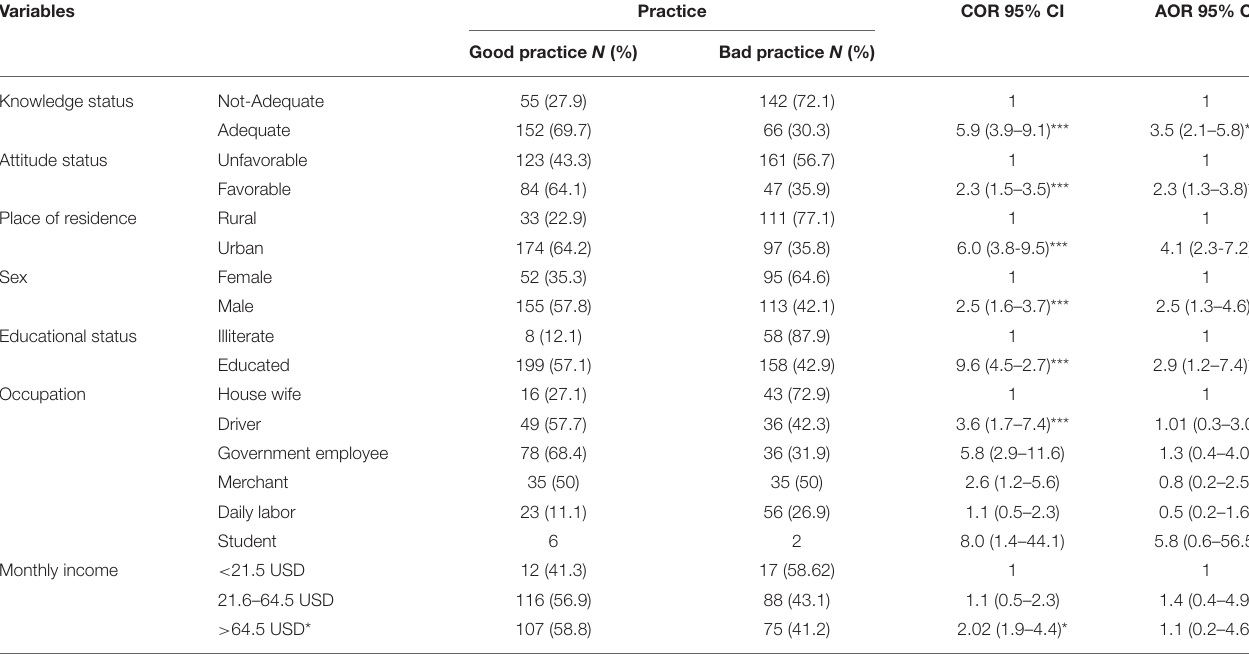
TABLE 6 | Factors associated with practice toward COVID-19 among Dire Dawa administration residents, Eastern Ethiopia, May